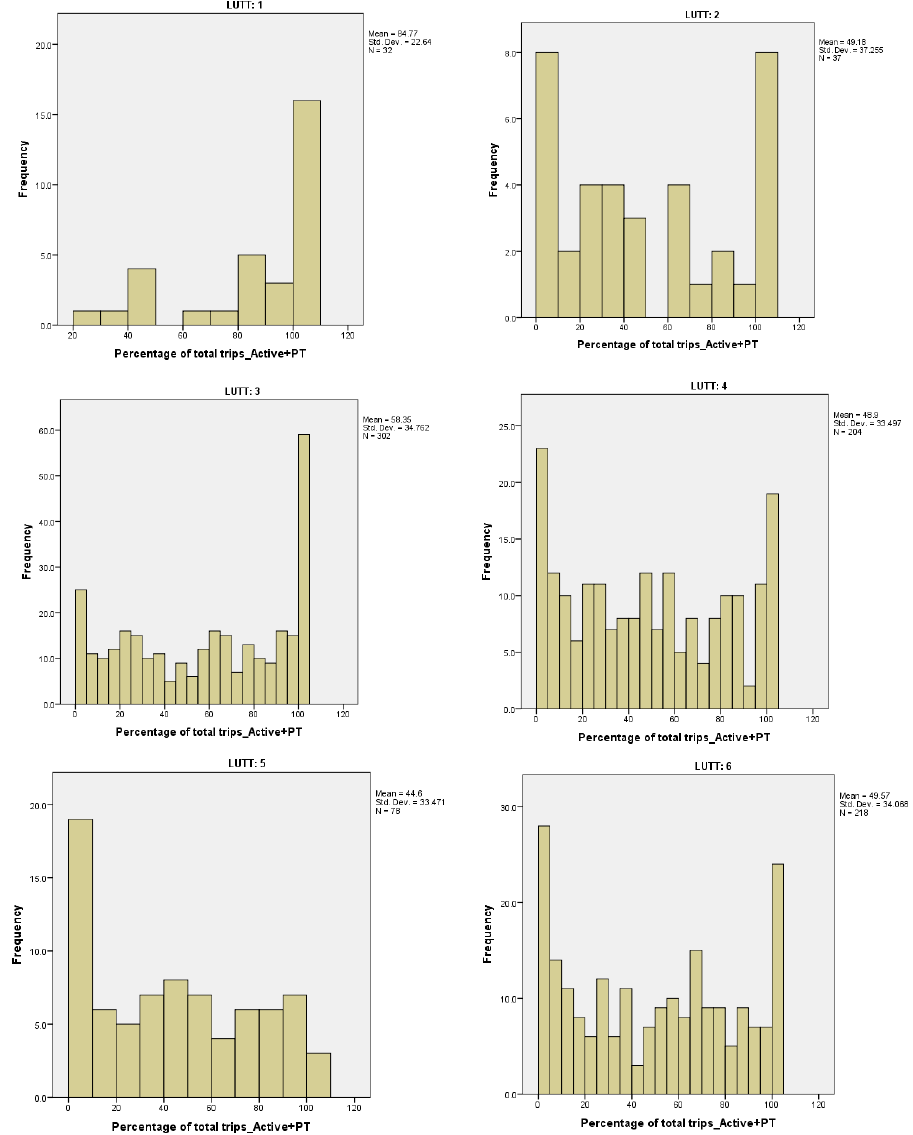
Figure A1. Distribution of the Proportion of Total Non-Work Trips using Active and Public Transport Modes in each LUTT.